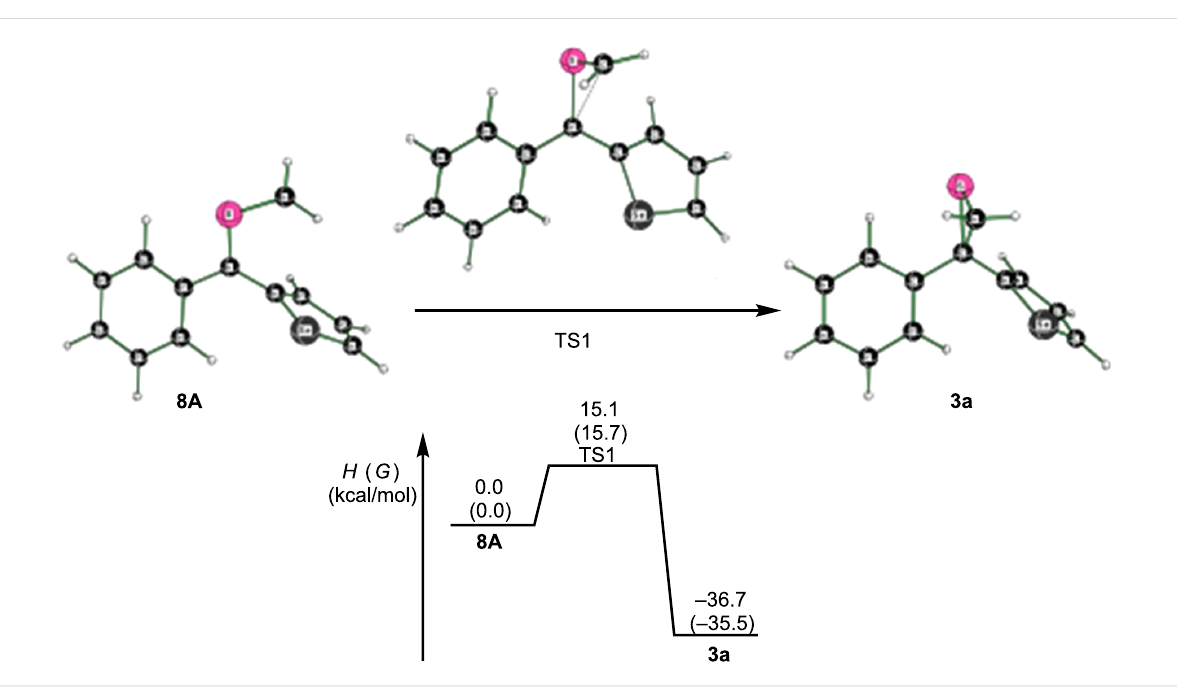
Figure 2: Potential 1,3-dipolar electrocyclization of thiocabonyl S -methanide 8A. Computed enthalpies (free energies in parentheses) at 298 K at the SMD(tetrahydrofuran)/M06-2X/6-311+G(2df,p)//M06-2X/6-31G(d) level of